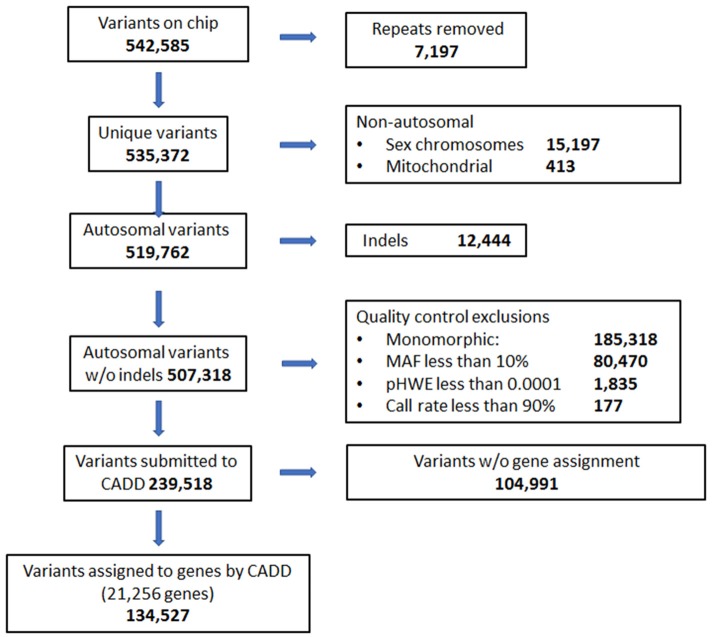
Quality control flow diagram and selection of genes and variants on exome chip to be used in analyses.